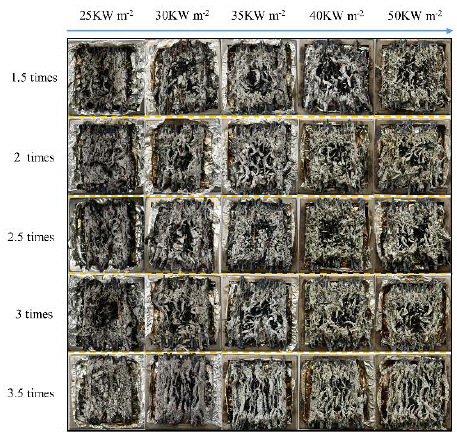
Figure 12. Image of the burning residue at various heat fluxes.